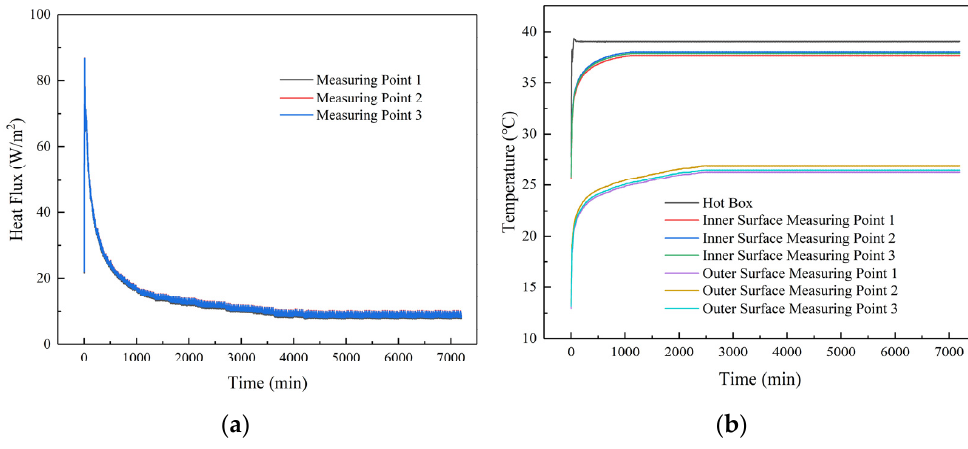
Figure 9. S-80XPS test data: ( a ) heat flux; ( b ) temperature. The average value of the three measuring points after data stabilization is used to reflect the overall heat insulation condition of the SIW wall panels. Similarly, the average value of data fluctuation is used to reflect B-490, except for invalid data from the initial measurement. As shown in Figure 11, there are average inner surface temperature, average outer surface temperature, and average heat flux from the test